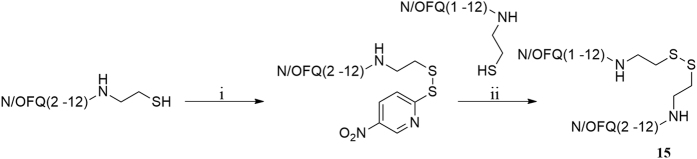
Synthesis of compound 15: (i) 2,2′-dithiobis(5-nitropyridine), CH3COOH/H2O 3:1, rt, 5 h; (ii) 1 M ammonium acetate buffer, rt, 30 min.